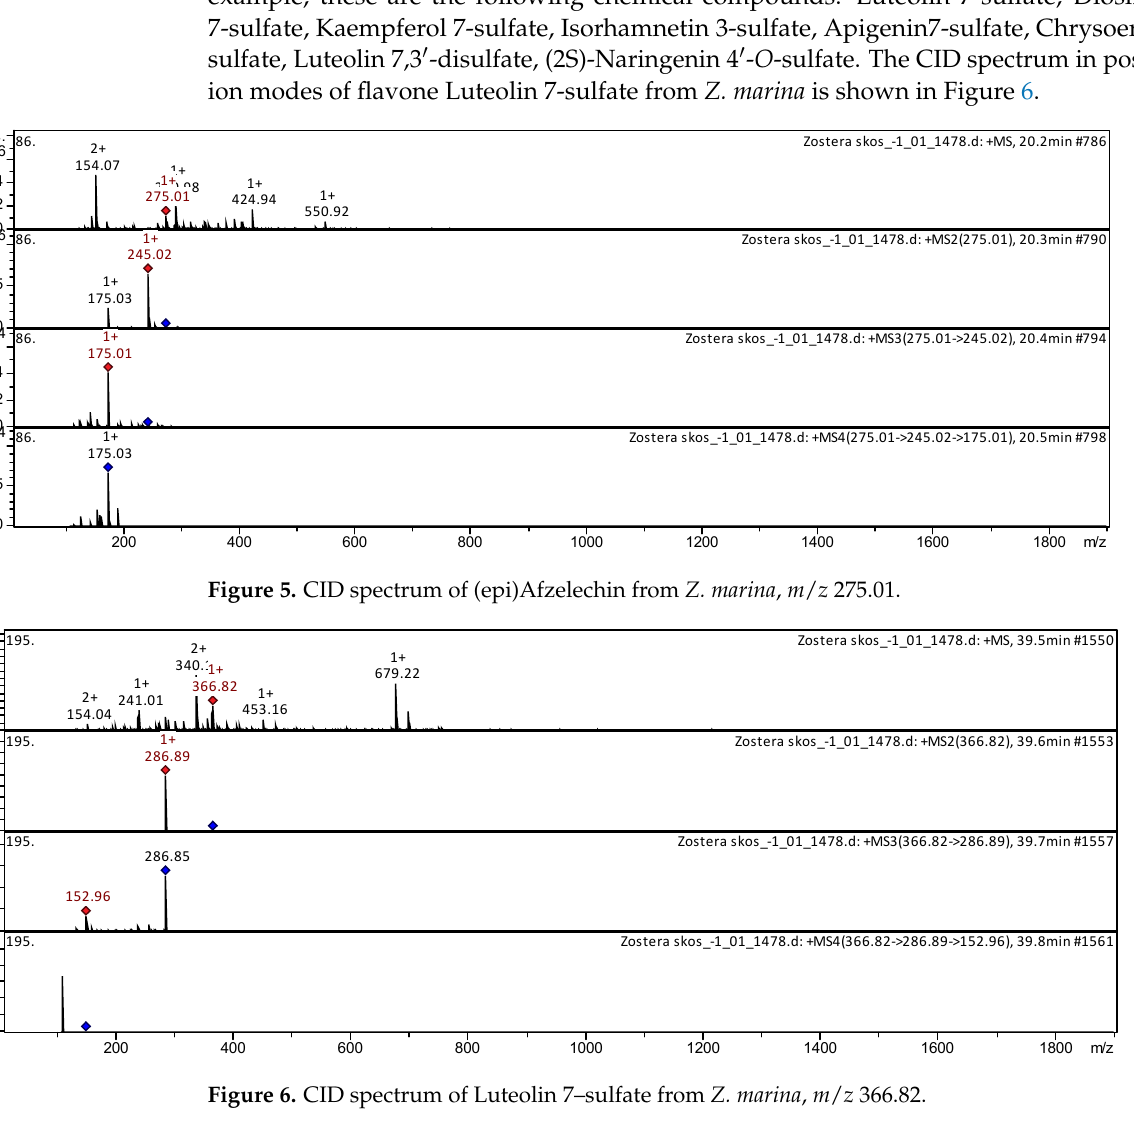
364.911- 348.951- 192.